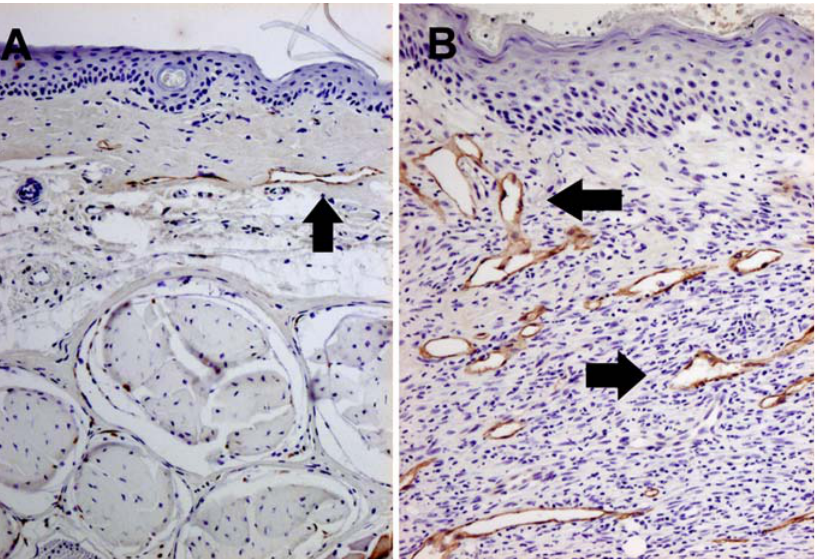
Figure 3. LYVE-1 Immunohistochemical Staining Immunohistochemical staining for LYVE-1 is depicted in surgical sham controls (A) and in lymphedema (B) (black arrows). The lymphedema response is characterized by the presence of numerous dilated microlymphatic structures in the dermis and subdermis. Lymphedema produces a statistically significant increase in average cross-sectional vessel area. DOI: